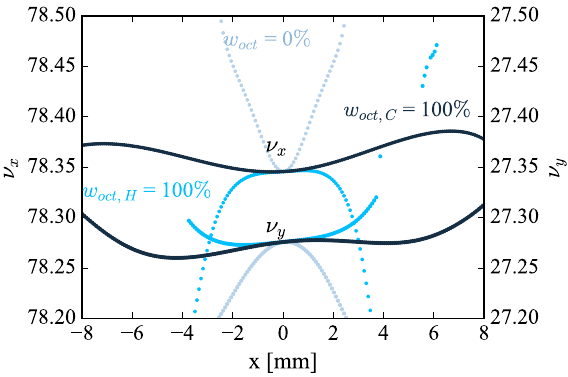
FIG. 7. Tune shift with horizontal amplitude in the case with 0% ), with oct only sextupoles ( w arbitrarily positioned oct ¼ H with respect to sextupoles, powered to cancel linear tune shift 100% ) and in the case with the triplet at the optimal ( w oct ; H ¼ 100% with w position oct C oct ; C ¼